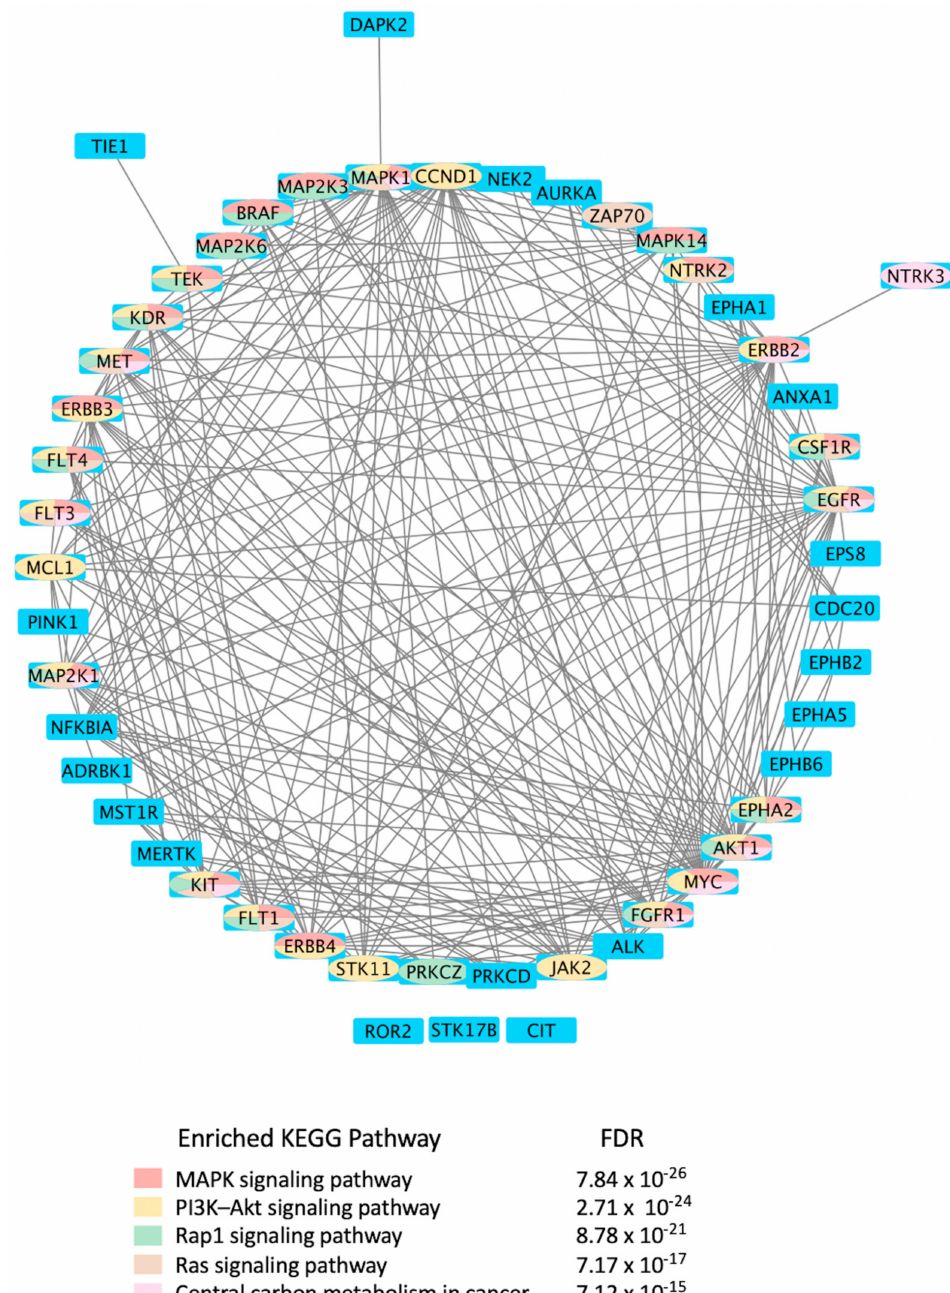
Figure 4. Protein-protein interactions network of kinases explored as diagnostic biomarkers for viral infections. Network nodes are human kinases that are viral disease biomarkers, according to the Cortellis Drug Discovery Intelligence databases [37]. The network was generated using Cytoscape version 3.9.1. Network nodes were colored based on the top five enriched KEGG pathways [73] shown in the color key beneath the network. Blue nodes indicate that the gene/gene product is not part of the top five enriched KEGG pathways shown underneath the network. The pathway prediction false discovery rate (FDR) is reported for each pathway. CDDI [37] was on https://www. cortellis.com/drugdiscovery/, accessed on 26 December 2022, ©2022 Clarivate. All rights